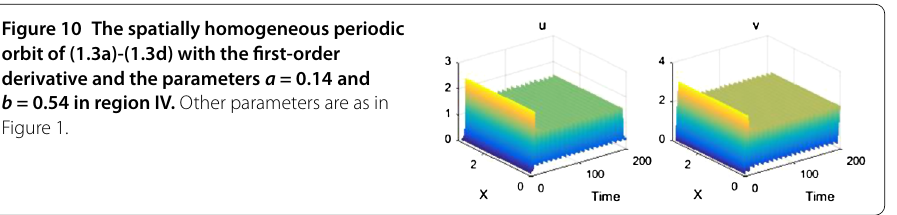
Figure 10 The spatially homogeneous periodic orbit of (1.3a)-(1.3d) with the first-order derivative and the parameters a = 0.14 and b = 0.54 in region IV. Other parameters are as in Figure